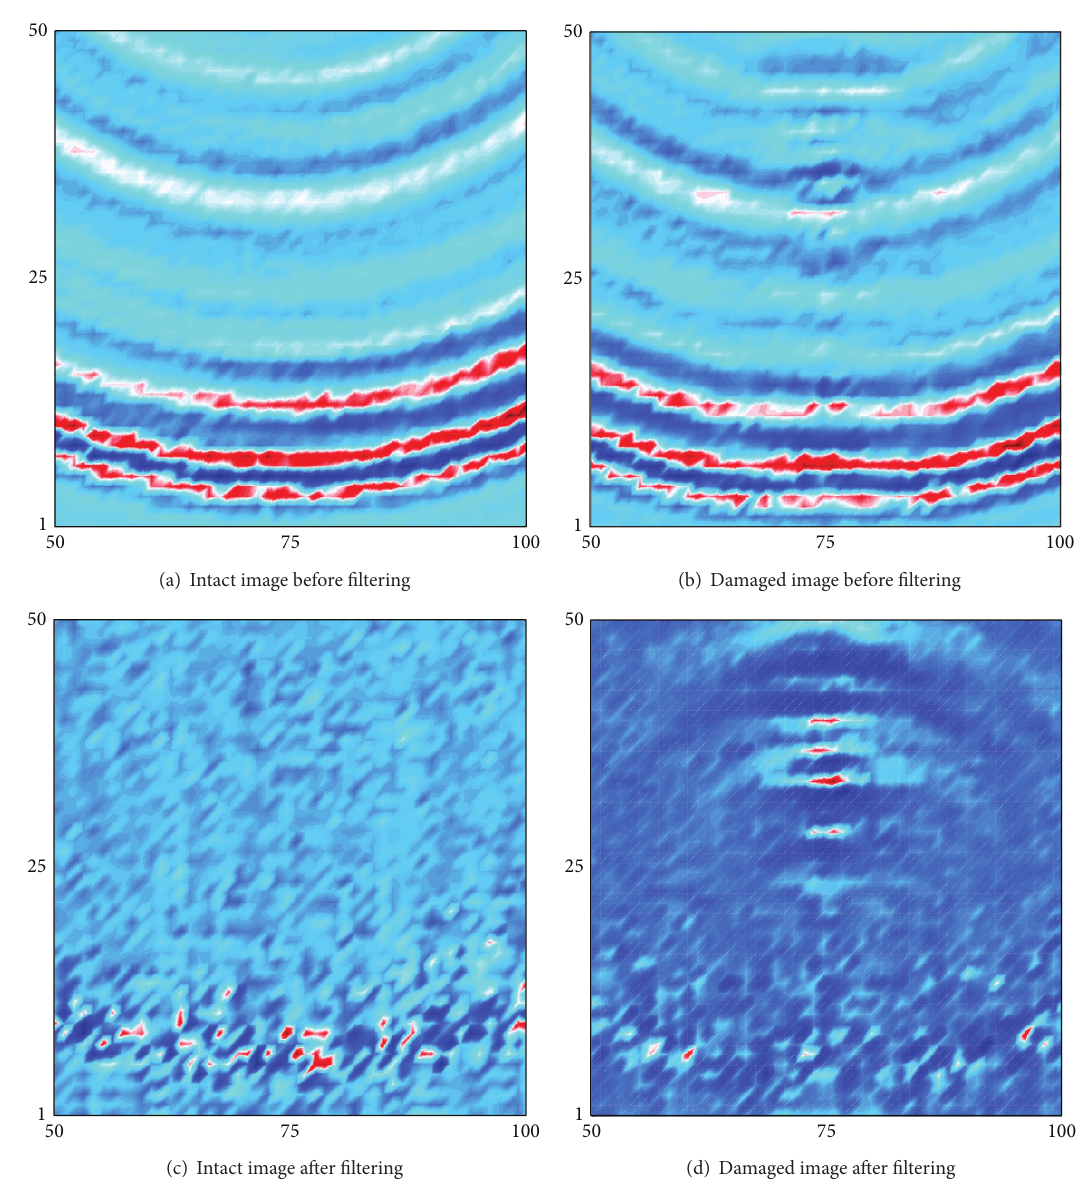
Figure 13: Comparison of UWPI snapshots at 48 𝜇 s for damage case